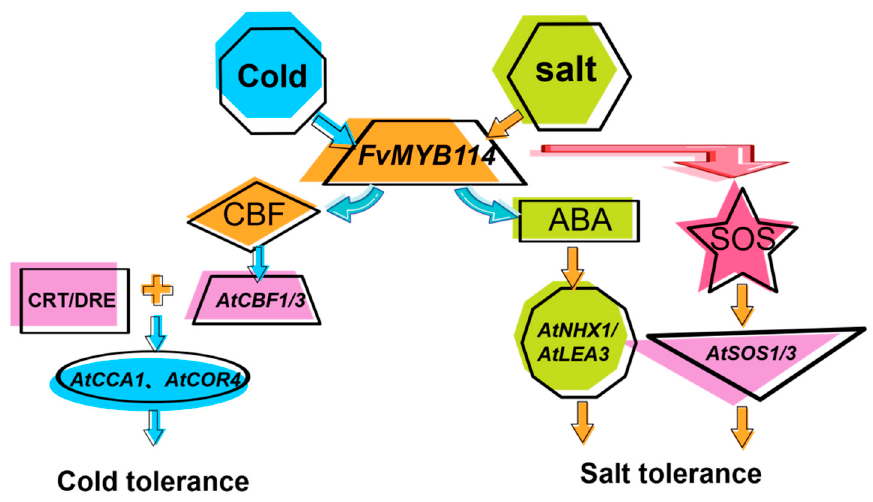
Figure 11. A possible functional model of FvMYB114 in response to low-temperature stress and salt stress. When subjected to cold stimulation, FvMYB114 upregulates the expression of cold response genes CBF1 , CBF3 , COR4 and CCA1 located through the CBF pathway. FvMYB114 binds to the pro- moter region of CBF1/3 , thereby promoting the binding of CBFs to the CRT/DRE cis-acting elements of genes, finally activating the expression of cold-related genes CCA1 and COR4. When receiving a salt stress signal, FvMYB114 can promote the expression of SOS1 and SOS3 through the SOS path- way and can also improve the expression levels of NHX1 and LEA3 genes through the ABA signal transduction pathway.